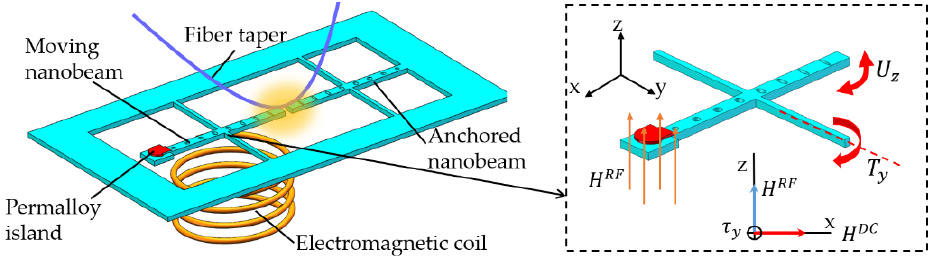
Figure 20. Split-beam PhC nanocavity for magnetic sensing (inset: mechanical profile of moving nanobeam under applied magnetic field Hz) [70].